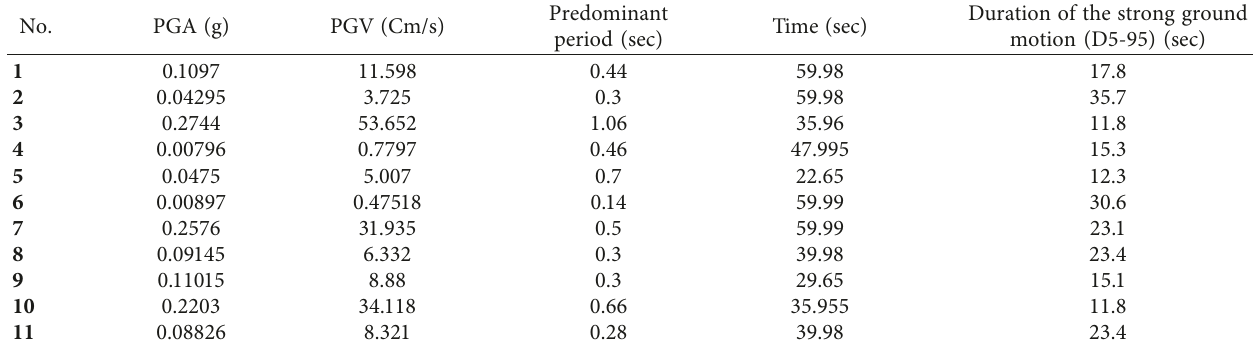
Table 4: Properties of acceleration records were calculated by the